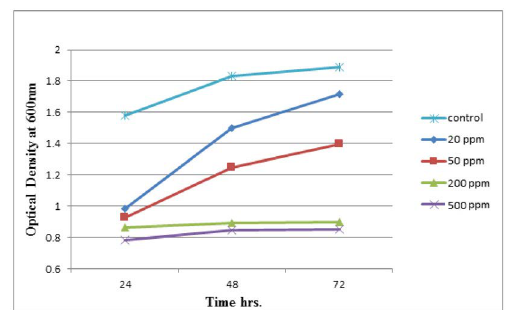
) at Fig. 11. Growth curve of isolate PS with (PbNO 2 different concentrations.